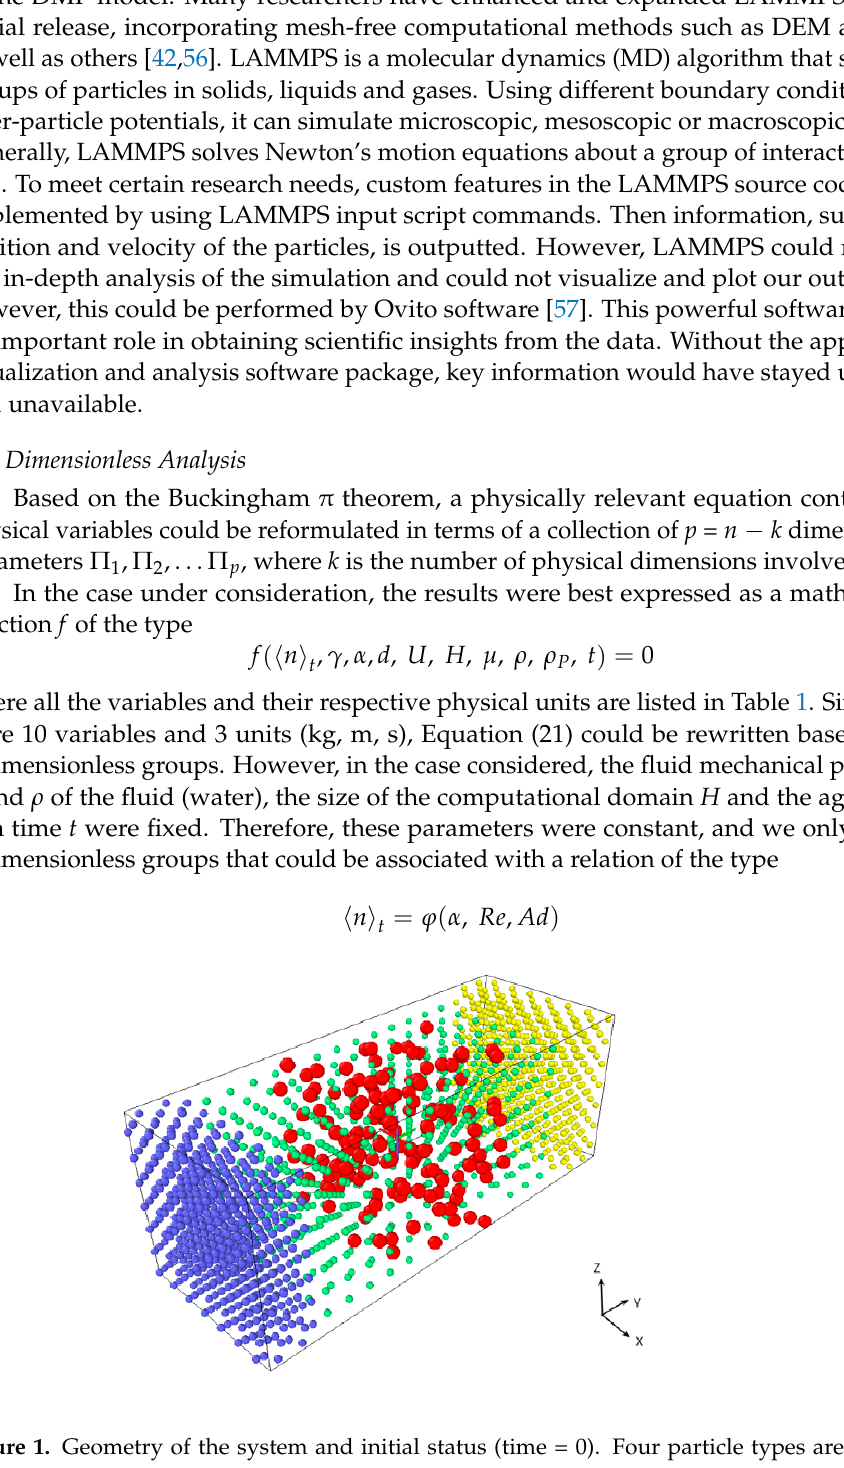
Table 2. Parameters used in the simulation of the structural evolution of solid particle agglomer- ates.